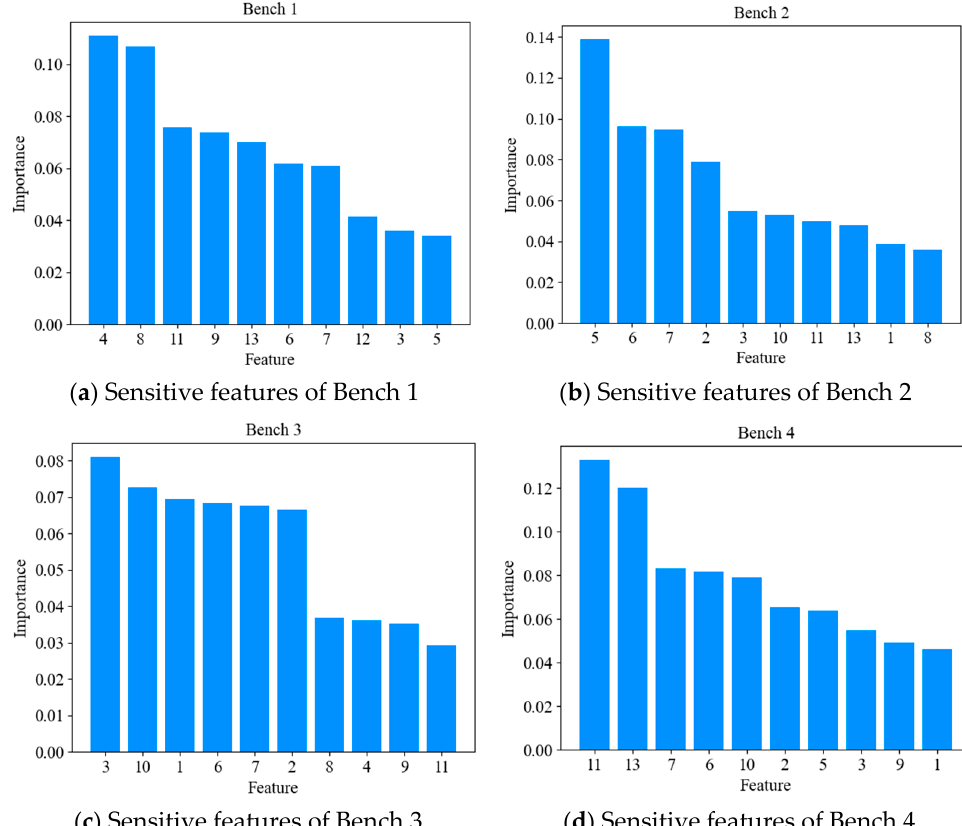
Figure 13. Random Forest feature importance ranking. Table 7. Accuracies of different classifiers under LSTM interval recognition.